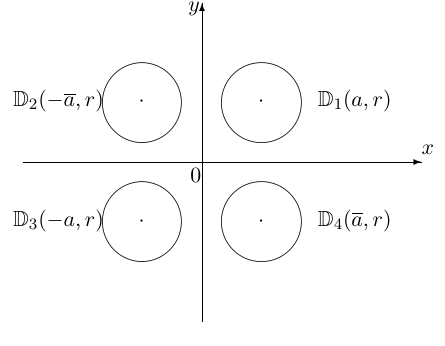
Figure 7. Four symmetrically situated